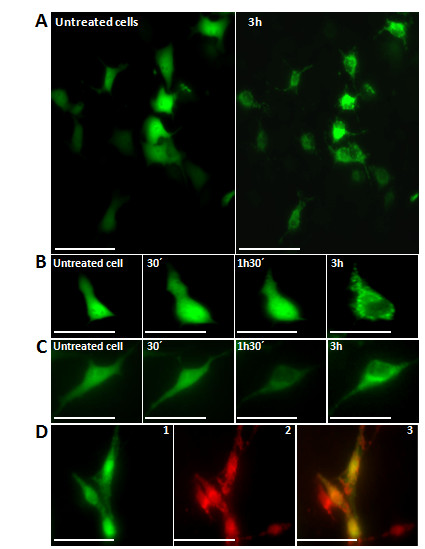
Bax translocation to mitochondria in GFP-Bax-transfected B16F10-Nex2 cells after treatment with C7a is dependent on Ca2+. (A) Representative images of untreated cells and after 3 h treatment; (B) Representative images after selected time points of an individual tumor cell; (C) The same assay performed in (B) with transfected cells preincubated with 20 μM of BAPTA before C7a addition; (D) Representative images show Bax-transfected C7a-treated cells after 2 h (1), co-stained with TMRE (2) and overlayed image (3). Scale bars, 20 μm in (A), 40 μm in (B) an (C) and 30 μm in (D). Images are representative of at least three individual experiments.